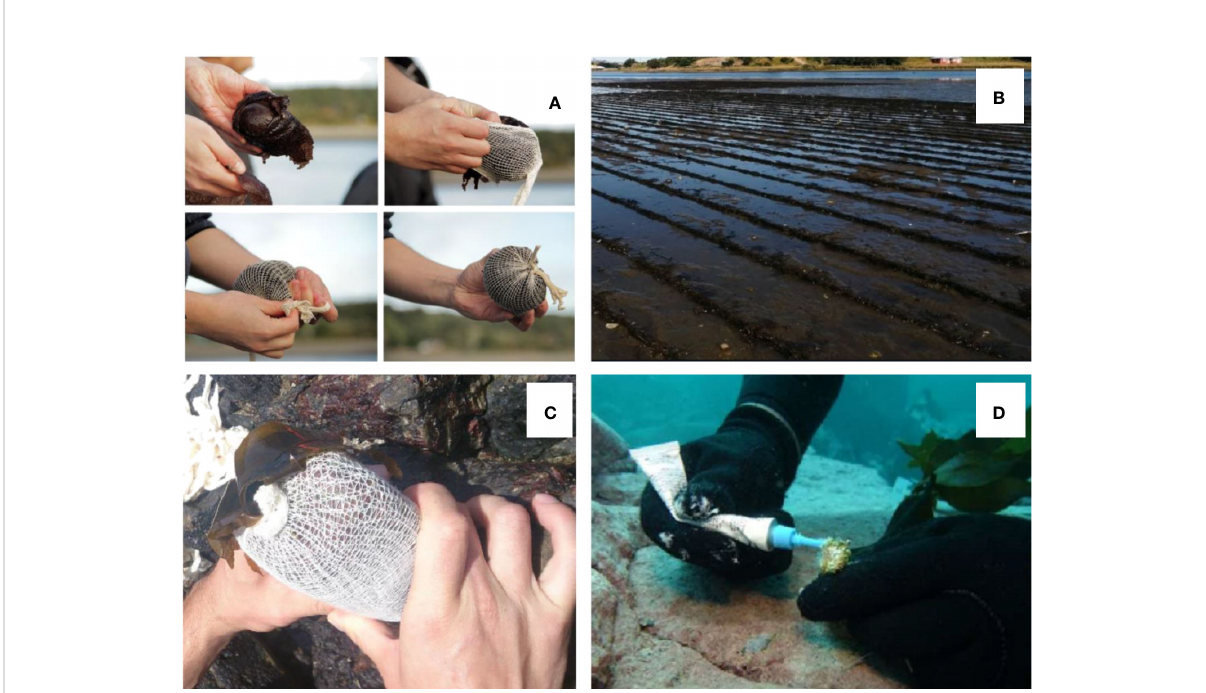
FIGURE 7 Photographs of algal restocking systems reported in the monitored TURF. (A) Repopulation system for Sarcothalia crispata reported in the Bajos de Lami by Ecos Consultores (2015). (B) Gracilaria chilensis restocking system recorded in Caulin, Chiloé in August 2020. (C) Repopulation system reported for Lessonia trabeculata in the Pajonales TURF by Bitecma Consultores (2015). (D) Experiment involving transplanting Lessonia trabeculata seedlings to a direct substrate with cyanoacrylate glue in the TURF of Chungungo by the Instituto de Fomento Pesquero (Henr ı ́ quez-Antipa et al.,